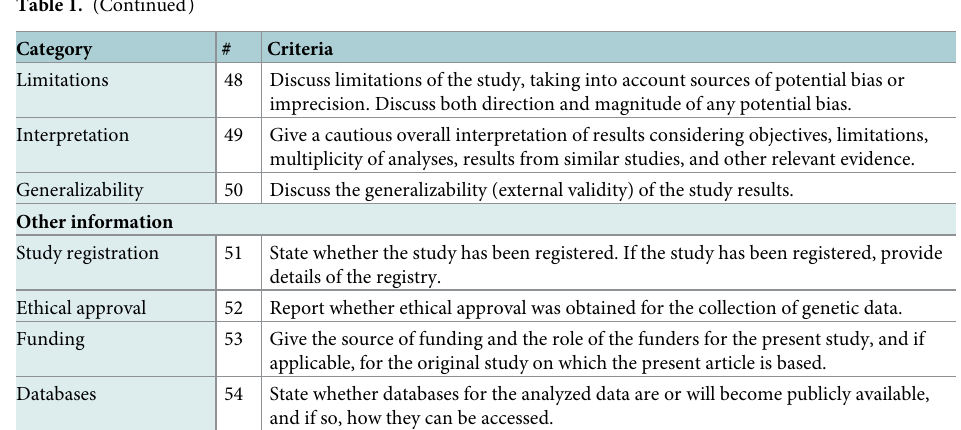
S1 Table. Items scored in the Delphi survey.